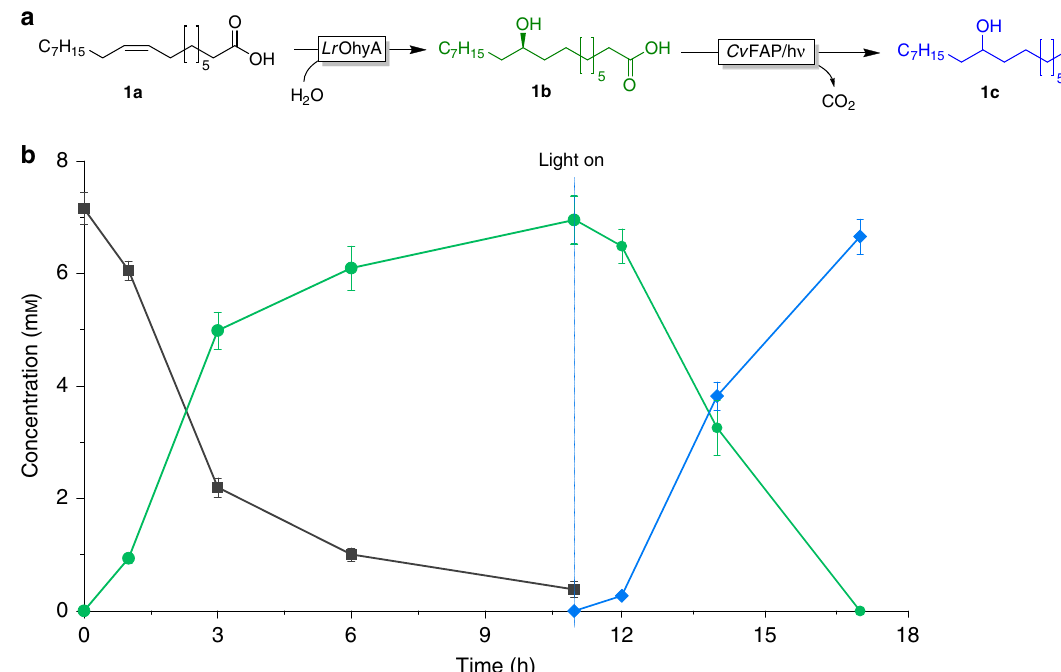
Fig. 3 Proposed photoenzymatic cascade to transform oleic acid into 9-heptadecanol. a : Recation scheme. b shows a representative time course of the cascade reaction. Reaction conditions: [oleic acid] = 7 mM, [ LrOhyA cells] = 15 g L − 1 , [ Cv FAP] = 2 µ M, Tris-HCl buffer pH 8.0 (100 mM, with 50 mM of NaCl), illumination with blue light ( λ = 450 nm; intensity = 13.7 mE L − 1 s − 1 ): oleic acid (black squares), 10-hydroxystearic acid (green circles), 9- heptadecanol (blue diamonds). Values represent the average of duplicates ( n = 2). Error bars indicate the standard